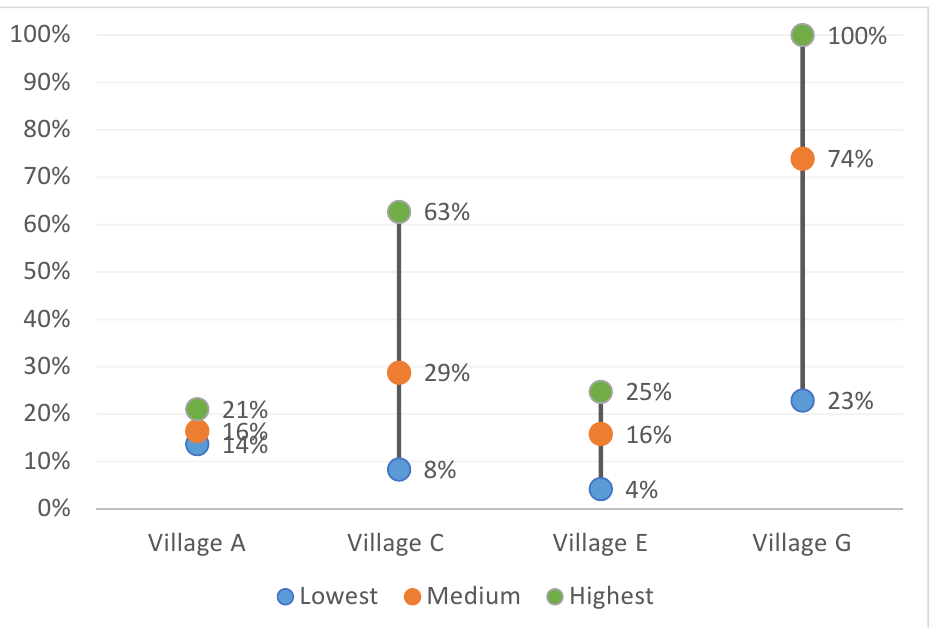
Figure 10. Contributions of PFES to total incomes in 2019. Source: compiled by the research team. According to participants in the men’s group meeting in Village B, between 2015 and 2019, villagers had no jobs due to droughts, crop failure and a disease epidemic, which led to hardships and bank debts. People in a group meeting in Village H, meanwhile, said, “From 2017 until now, there have been steady crop losses, low latex prices have made the village economy difficult. In 2010, at the end of the season four tons of cashews could be harvested from each hectare. Now we can only harvest around 200 kg”. Participants in the women’s group meeting in Village G also said, “Cashew crops have failed over the last three years, and we have survived so far because of forest money”. In Village A, head